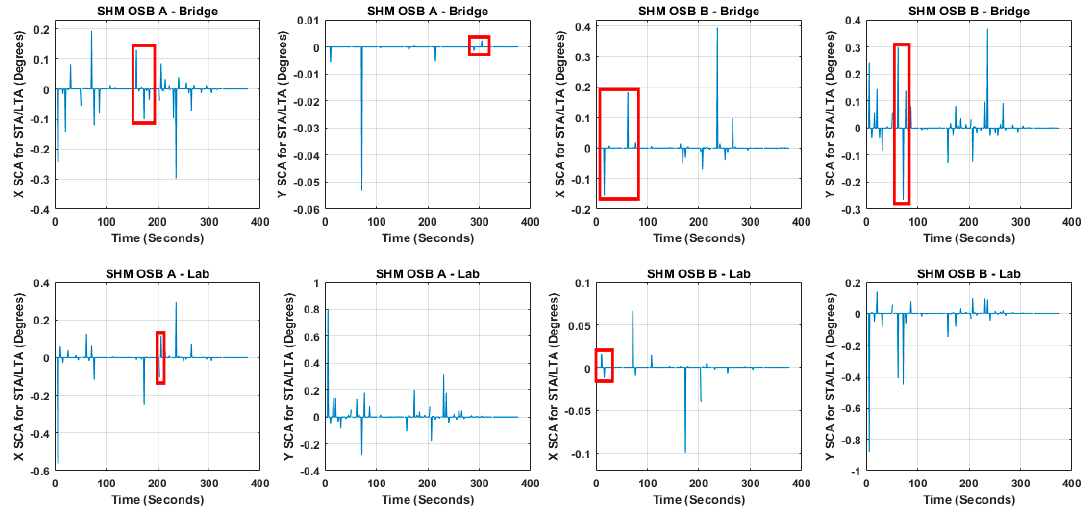
Figure 22. Peak detection sequence (PDS)/autoregressive pattern mapping sequence (APMS) for SCAG for extracted signals for two sites (structured waves mapped = 6).